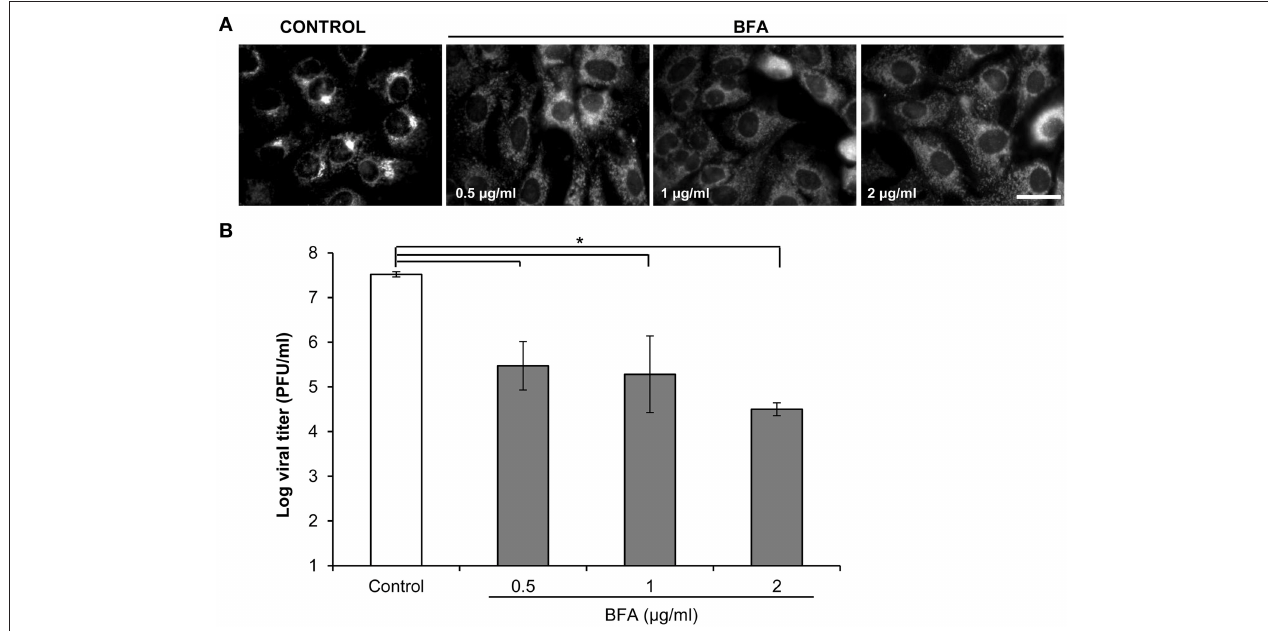
FIGURE 2 | BFA inhibits SVDV production in a dose-dependent manner. (A) IBRS-2 cells treated with different concentrations of BFA for 30 min were fixed and processed for immunofluorescence using a MAb against the cis -Golgi. (B) IBRS-2 cells treated with BFA as in (A) were infected with SVDV (moi of 0.5 pfu/cell) in presence of the drug. At 8 h pi the viral titer was determined by plaque assay. Error bars represent SD. The data presented correspond to two independent experiments. Data were analyzed using ANOVA. Asterisk ( * ) denote statistically significant differences with P < 0.05.